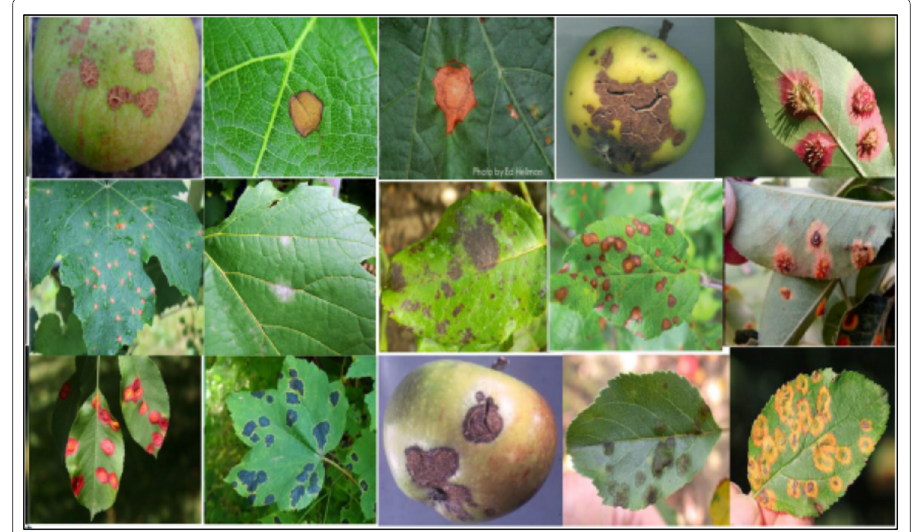
Fig. 8 Sample images for the identification of infection parts using the proposed segmentation